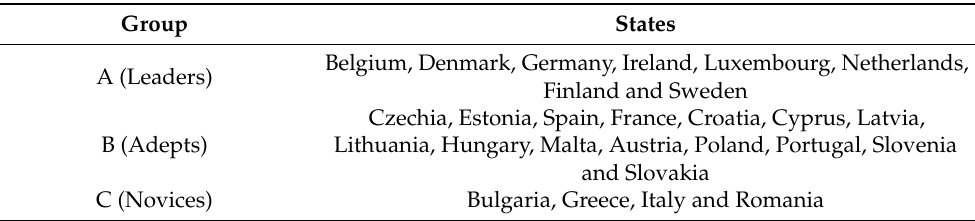
Table 4. Structure of the groups of EU member states in terms of the development level of Internet purchases by individuals in